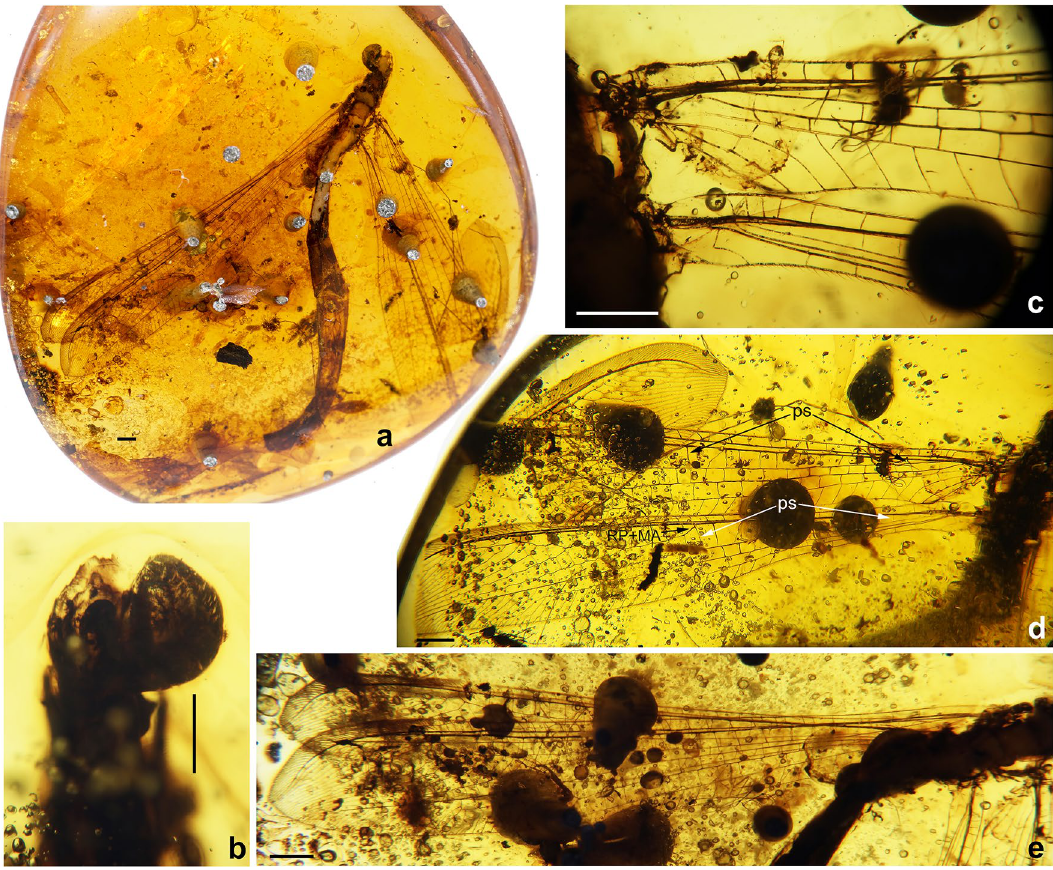
Figure 4. Stenobabinskaia punctata sp. nov., holotype male. ( a ) habitus photograph, dorsal view; ( b ) photograph of head and prothorax, dorsal view; ( c ) photograph of bases of right wings; ( d ) photograph of right wings; ( e ) photograph of left wings. Scale bar = 1.0